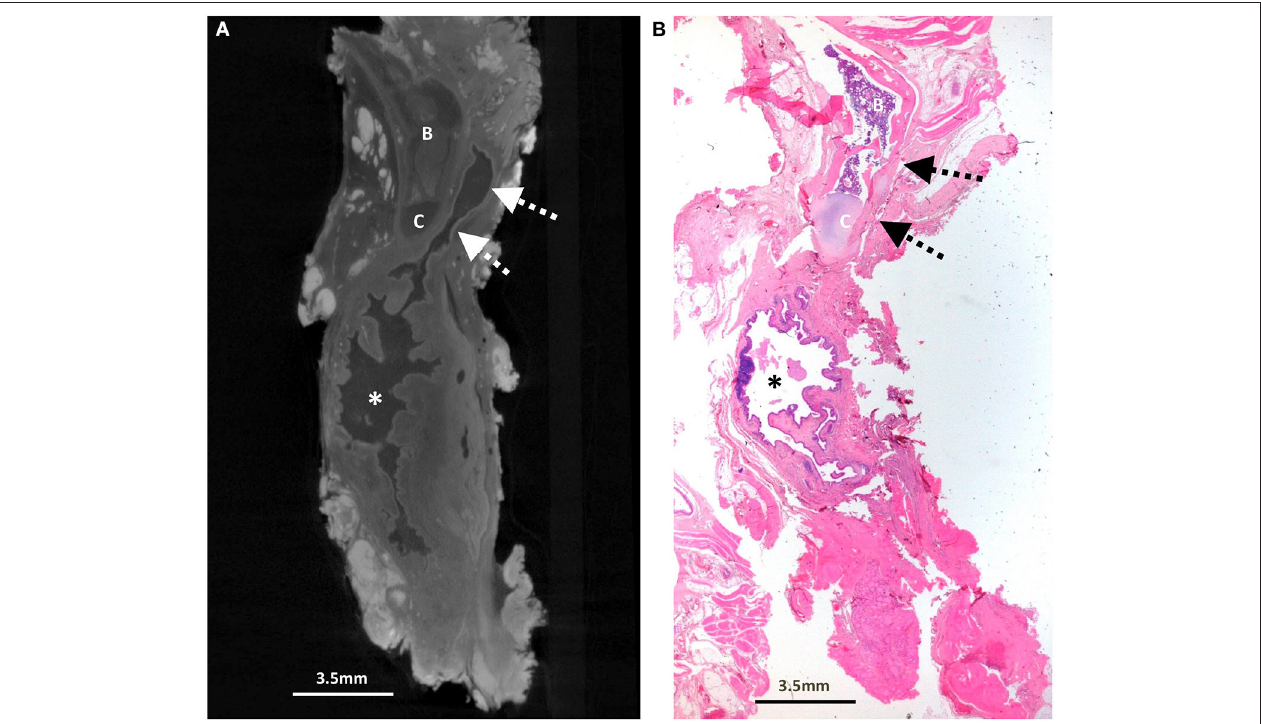
FIGURE 1 | Excised thyroglossal duct cyst specimen from a 4-year-old female patient (case 1). (A) Paired iodinated micro-CT imaging at 17.3 micron resolution and (B) histopathological section with H&E staining in sagittal section demonstrate the thick-walled thyroglossal duct cyst (*) and the thyroglossal duct (dashed arrows) anterior to the hyoid bone (B) and hyoid cartilage